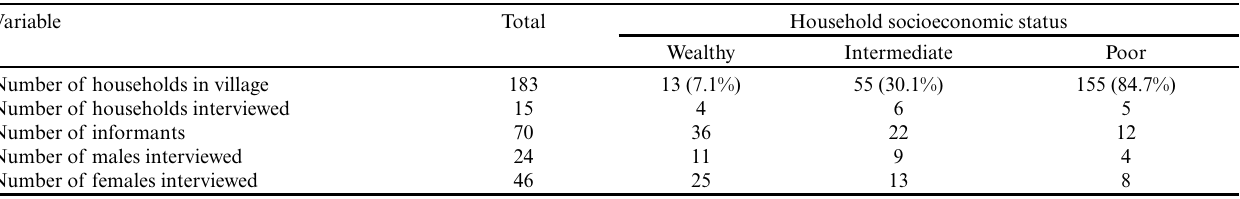
Table 1. Characteristics of the survey